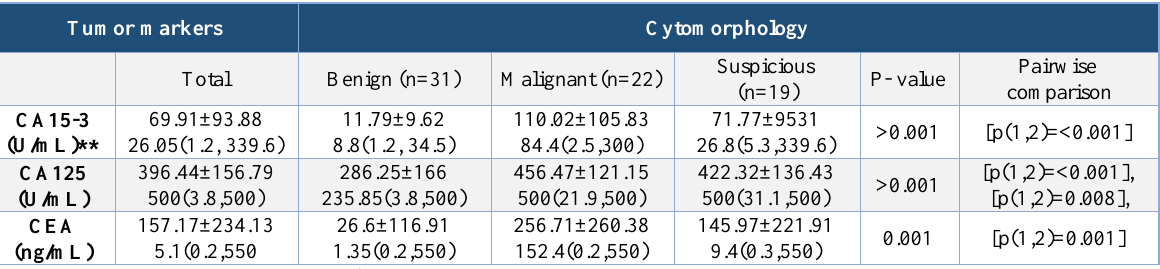
Table 2 . Serosal fluid levels of CA15-3, CA 125, and CEA in three cytology groups (Mean ± SEM).